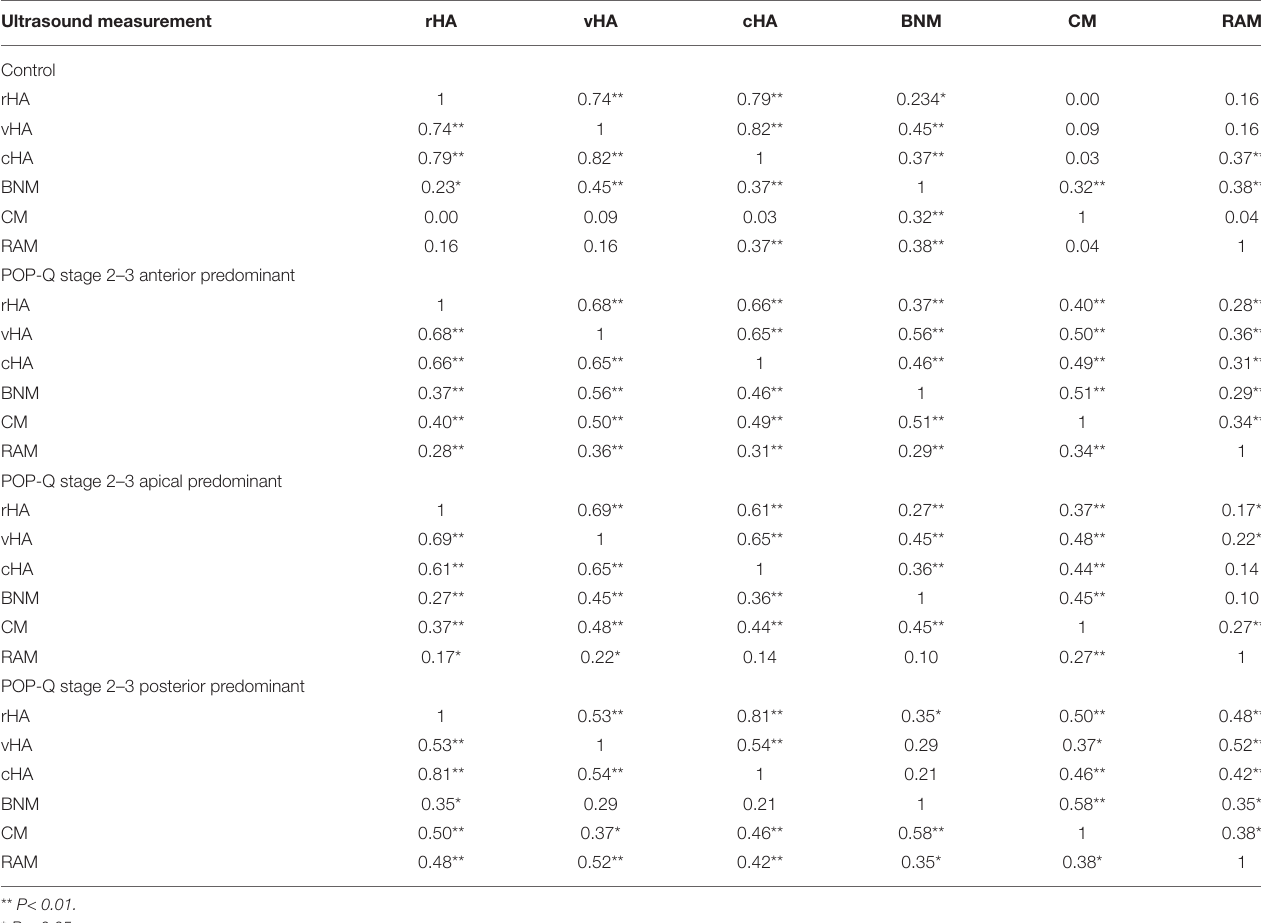
TABLE 2 | Pearson correlation coefficient between any two of six ultrasound measurement of hiatal area (HA) at reast (rHA), on Valsalva (vHA), and on maximum contraction (cHA) and bladder neck mobility (BNM), cervix mobility (CM), and rectum ampulla mobility (RAM). Ultrasound measurement